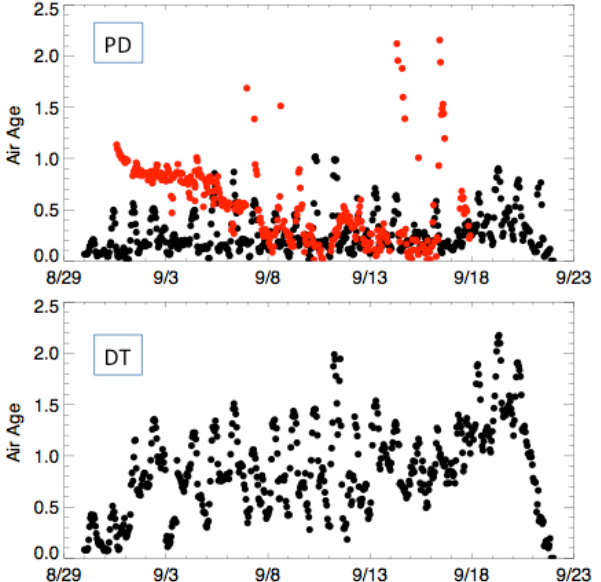
Fig. 7. The measured and calculated chemical age at the PD site (upper panel) and calculated age at the DT site (lower panel) during the experiment. The black and red dots represent the calculated and measured ages at the PD site, respectively.